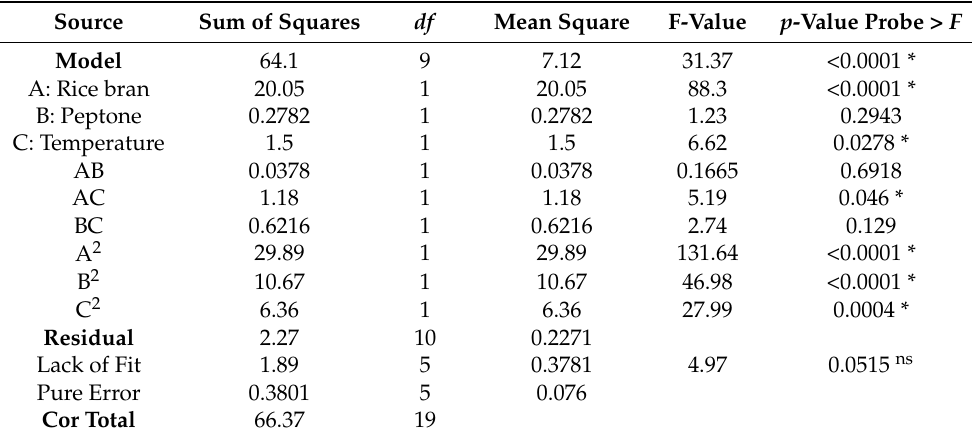
Table 3. ANOVA for PHB production as a function of independent